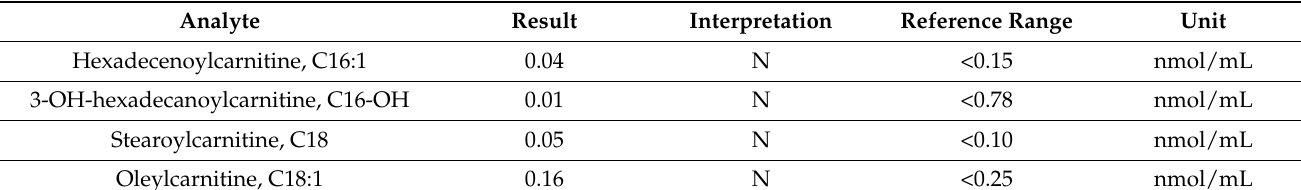
Table 1. Cont. Table 2. Plasma and CSF levels of serine and glycine of the patient before and after the treatment